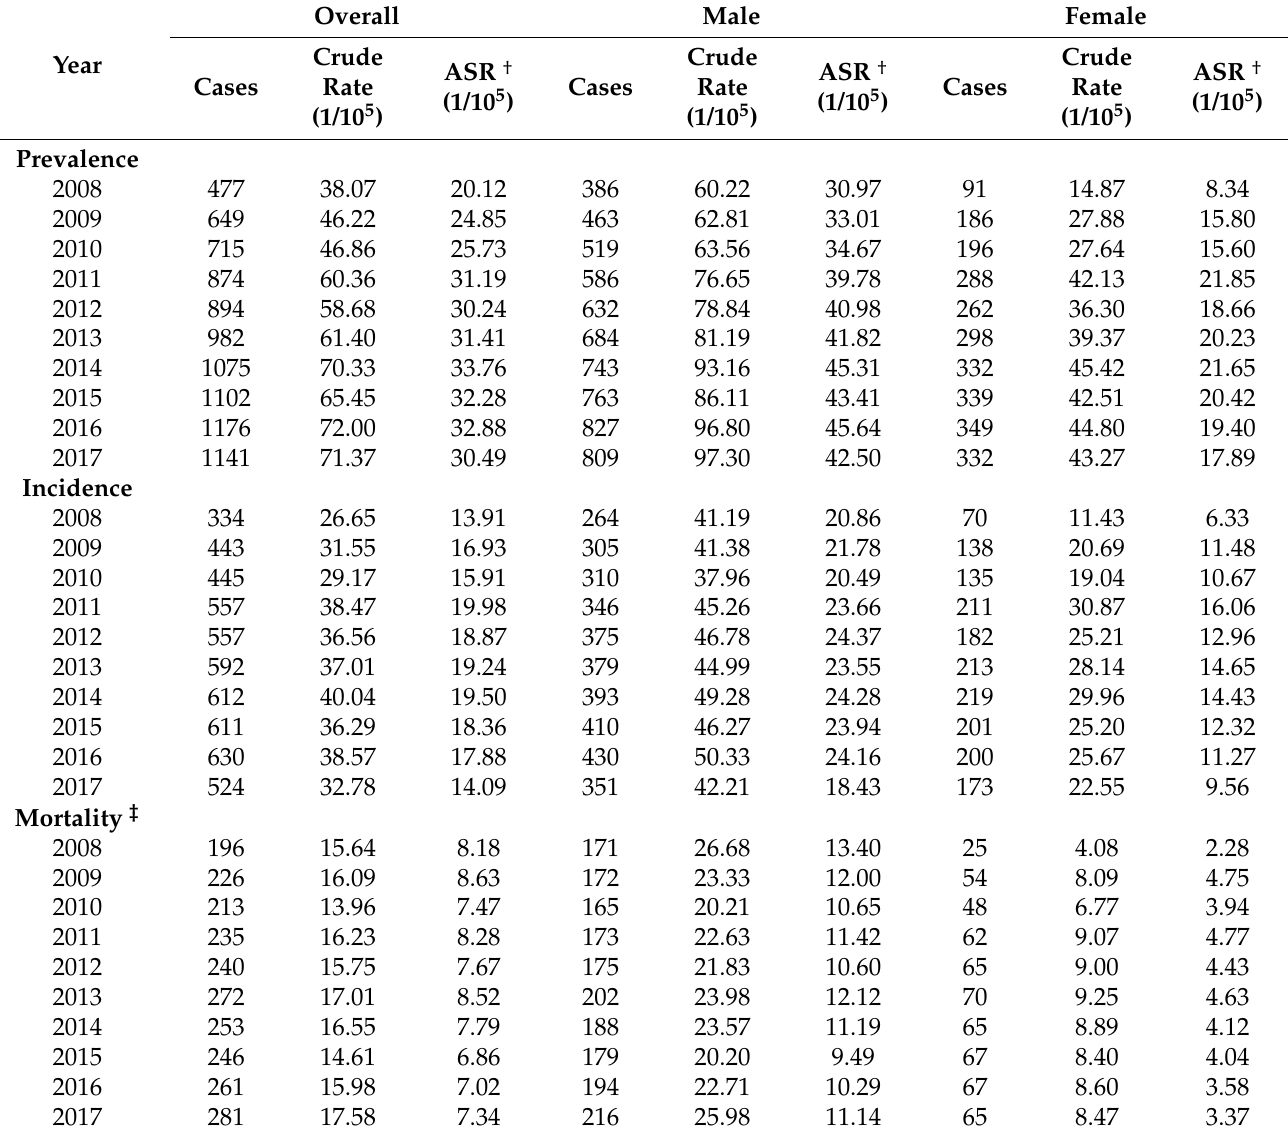
Table 1. Estimated prevalence, incidence, and mortality of HCC from 2008 to